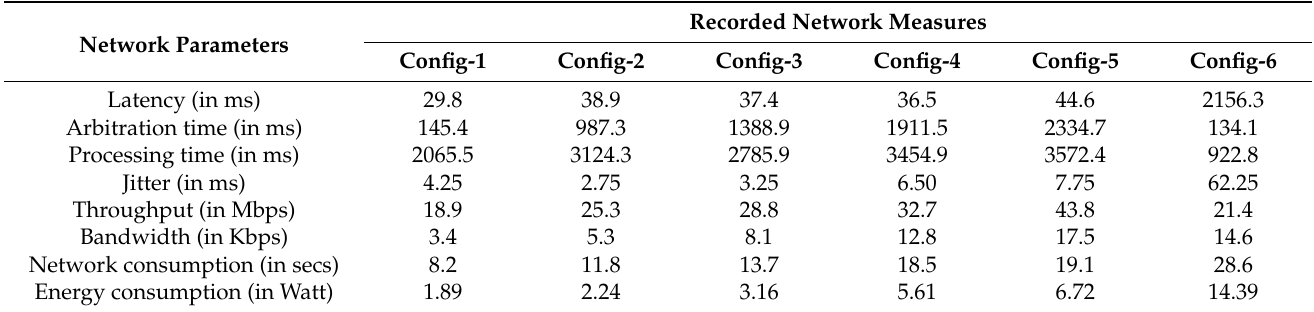
Table 8. Recorded results of network parameters based on various proposed